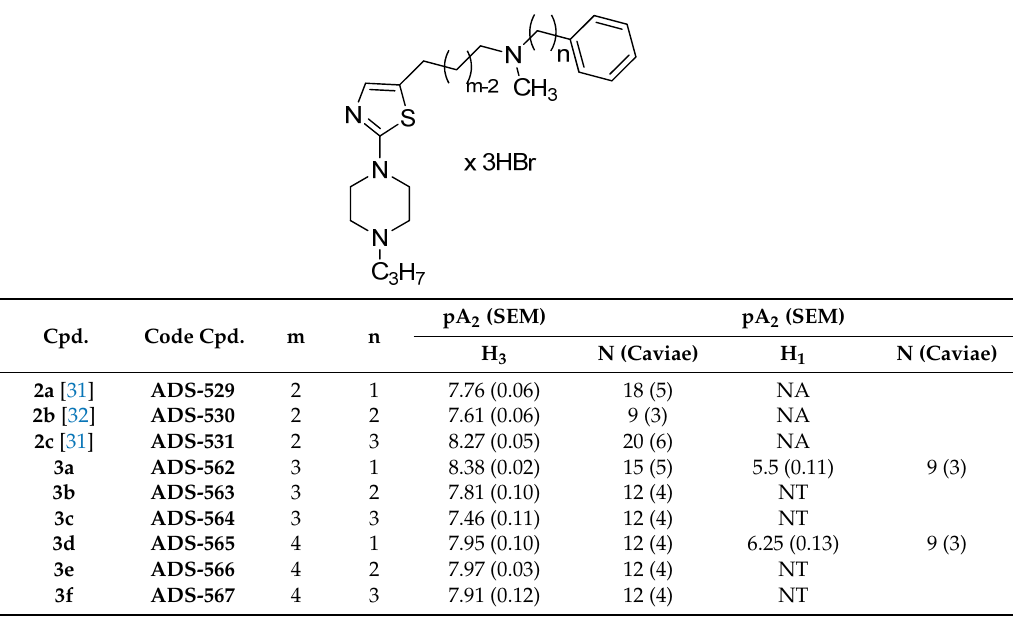
Table 1. H 3 - and H 1 -antagonistic potency of compounds 2a–c and 3a–f as tested in the in vitro test system in the guinea pig jejunum.